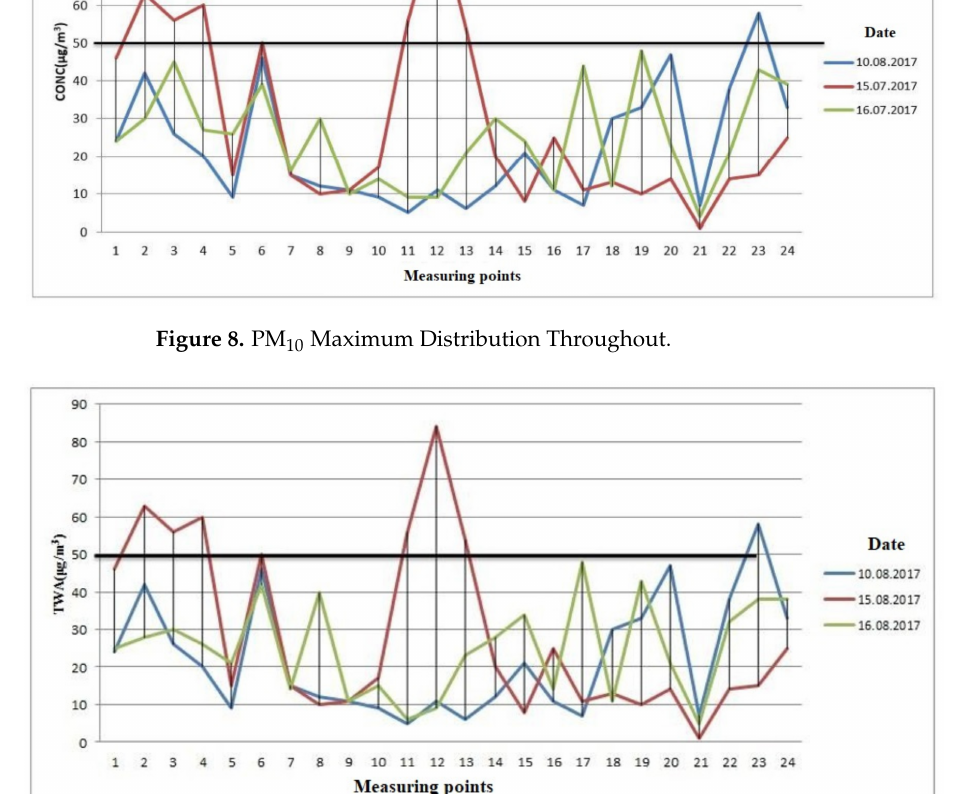
Figure 9. PM 10 Average Distribution Throughout.